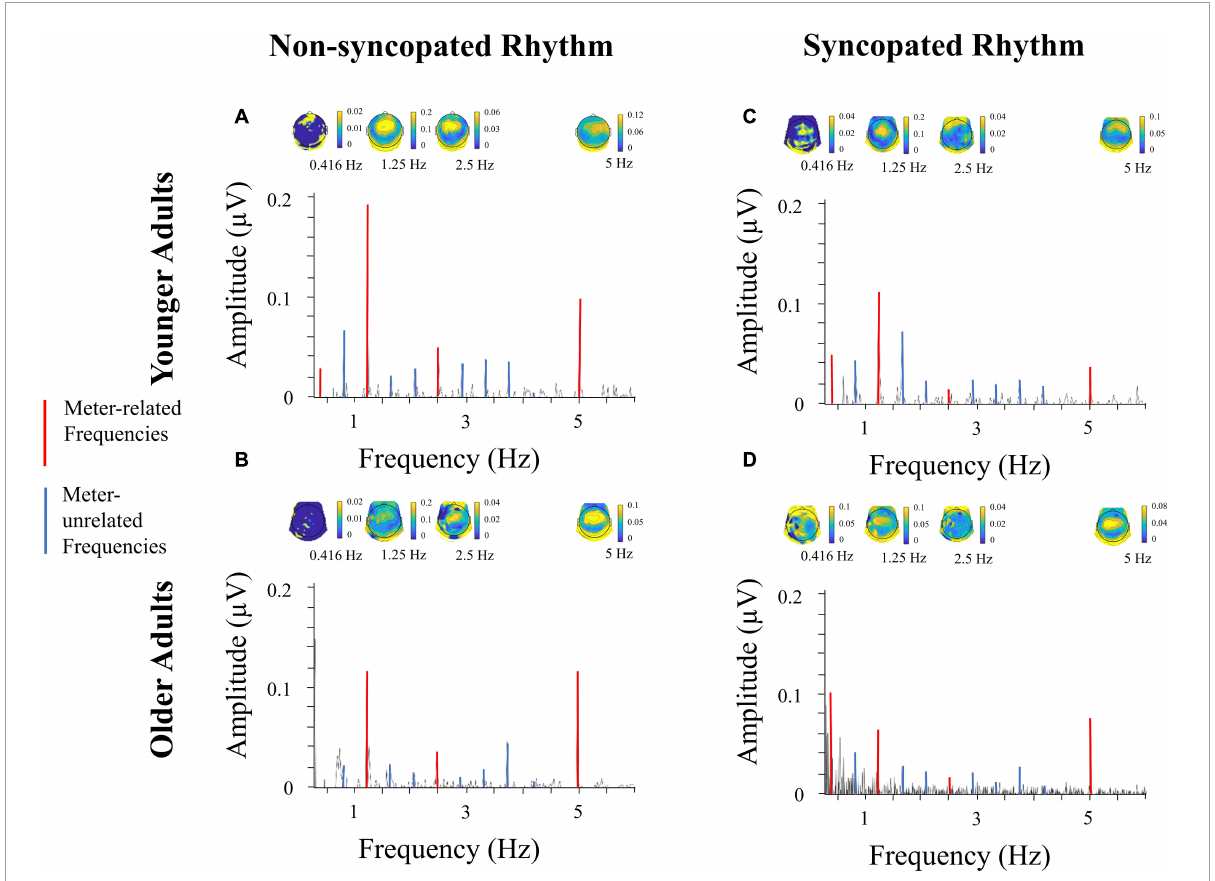
FIGURE3 EEG spectra, slow tempo. Amplitude of neural activity at electrode Cz ranging from 0.5 to 6 Hz for younger adults (A,C) and older adults (B,D) adults for non-syncopated (A,B) and syncopated (C,D) rhythms for slow tempo , along with topographic maps corresponding to each meter-related frequency. Frequency and amplitude scales are identical across conditions and groups to allow direct comparison across spectra. The scales of the topographical maps are adjusted for each condition, group and frequency for optimal visualization of topographical distribution across the EEG channels. Each topographical map corresponds to a meter-related frequency, shown in